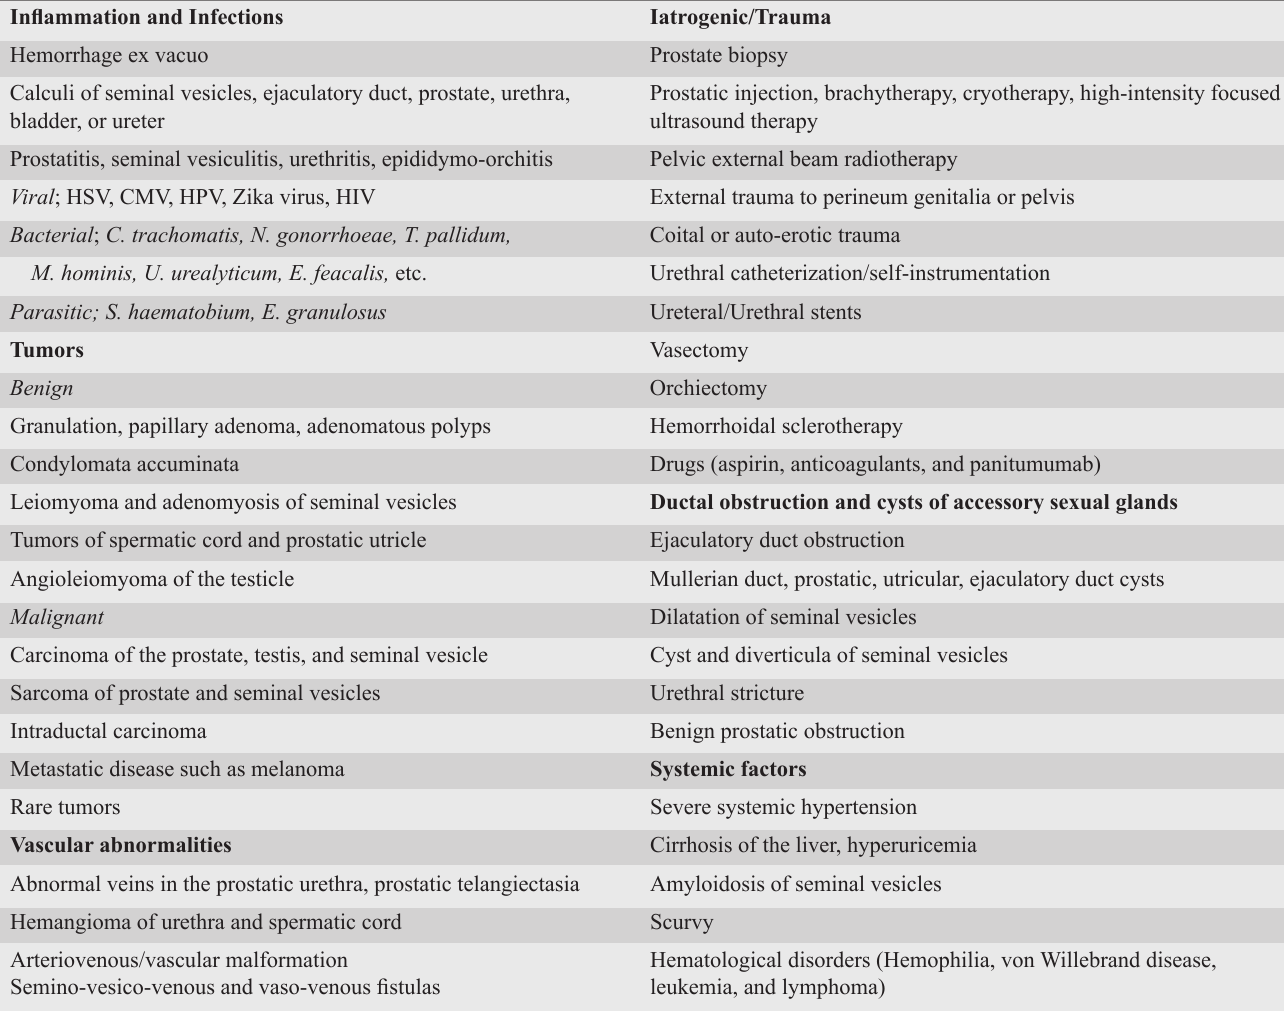
Table 1. Etiology of Hematospermia, Modified From Suh et al. 3 Inflammation and